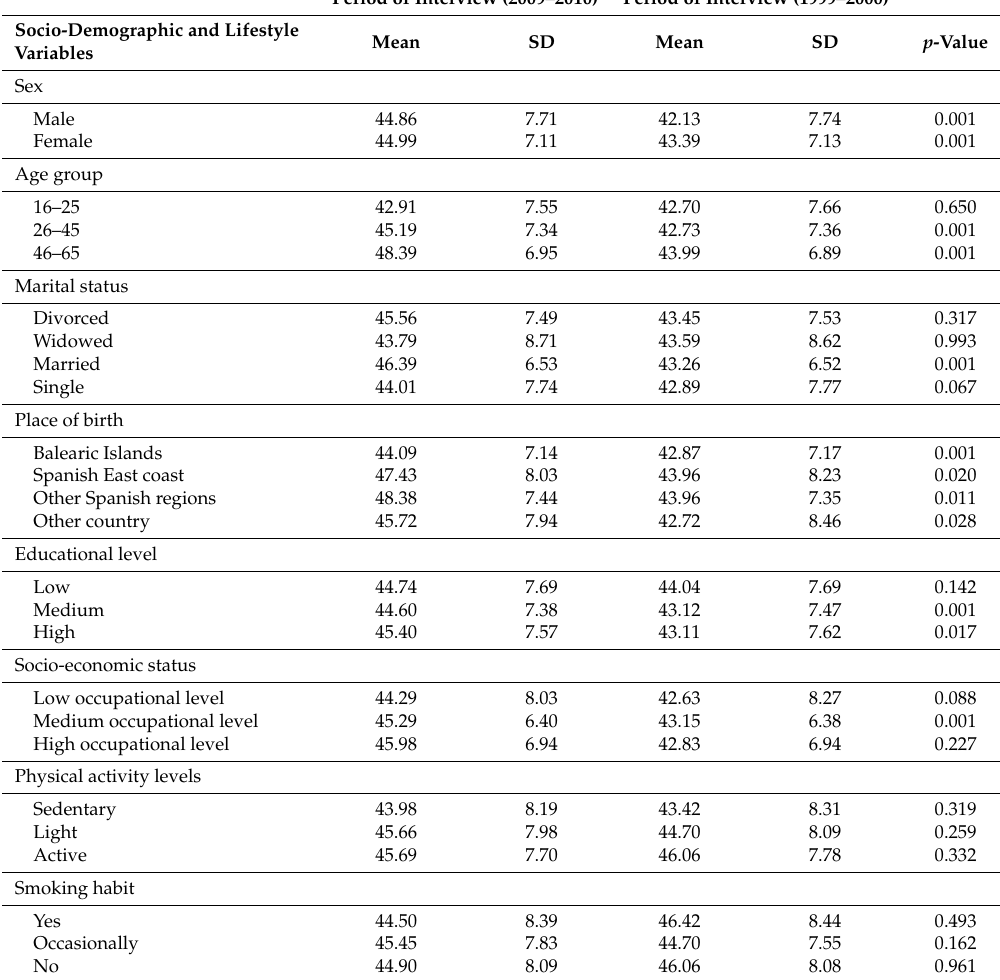
Table 2. Percentage of adherence to the MDP according to period of interview and selected socio-demographic and lifestyle variables.